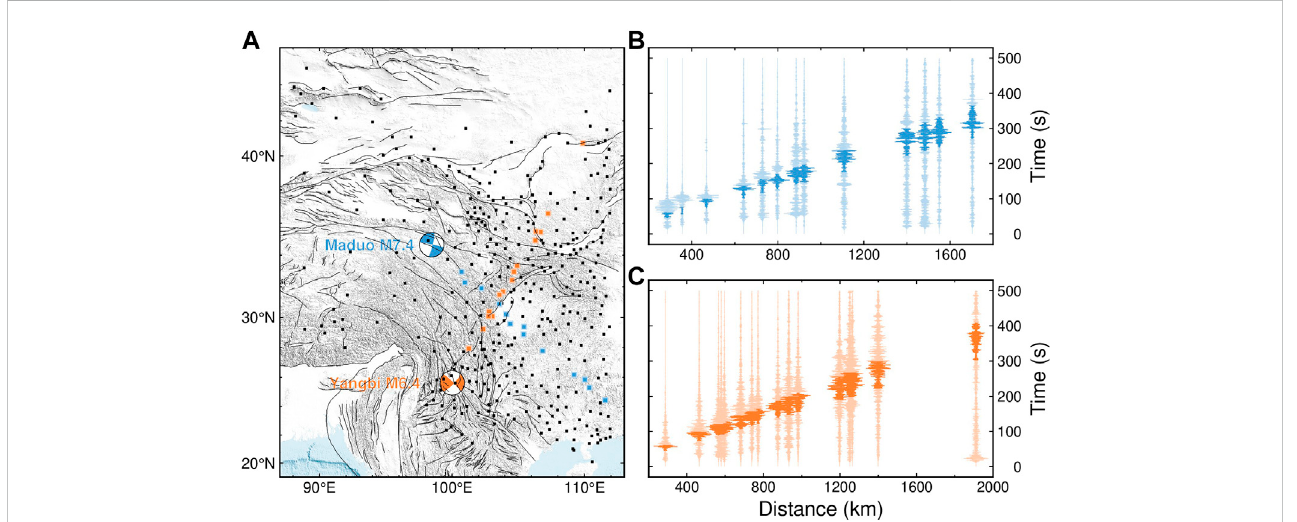
FIGURE 2 Mapofthedistributionofstationsusedinthisstudy (A) andillustrationsofseismograms (B,C) . (A) Stationsarerepresentedby fi lledsquares.Locationsand focal mechanisms of the 2021 May Yangbi and Maduo earthquakes are indicated by orange and blue beach balls, respectively. Orange and blue squares representstationsselectedtoshowtheirrecordingsfortheYangbiandMaduomainshocks,respectively. (B,C) Waveformsare fi lteredbetween0.5and1.0 Hz to improve the Lg demonstrations and are aligned with a reduced velocity of 8.4 km/s. Typical group velocities of the Lg phase, 3.6 – 3.0 km/s, are highlighted. The Lg-wave group velocity window can be slightly adjusted for each trace to capture the maximum energy